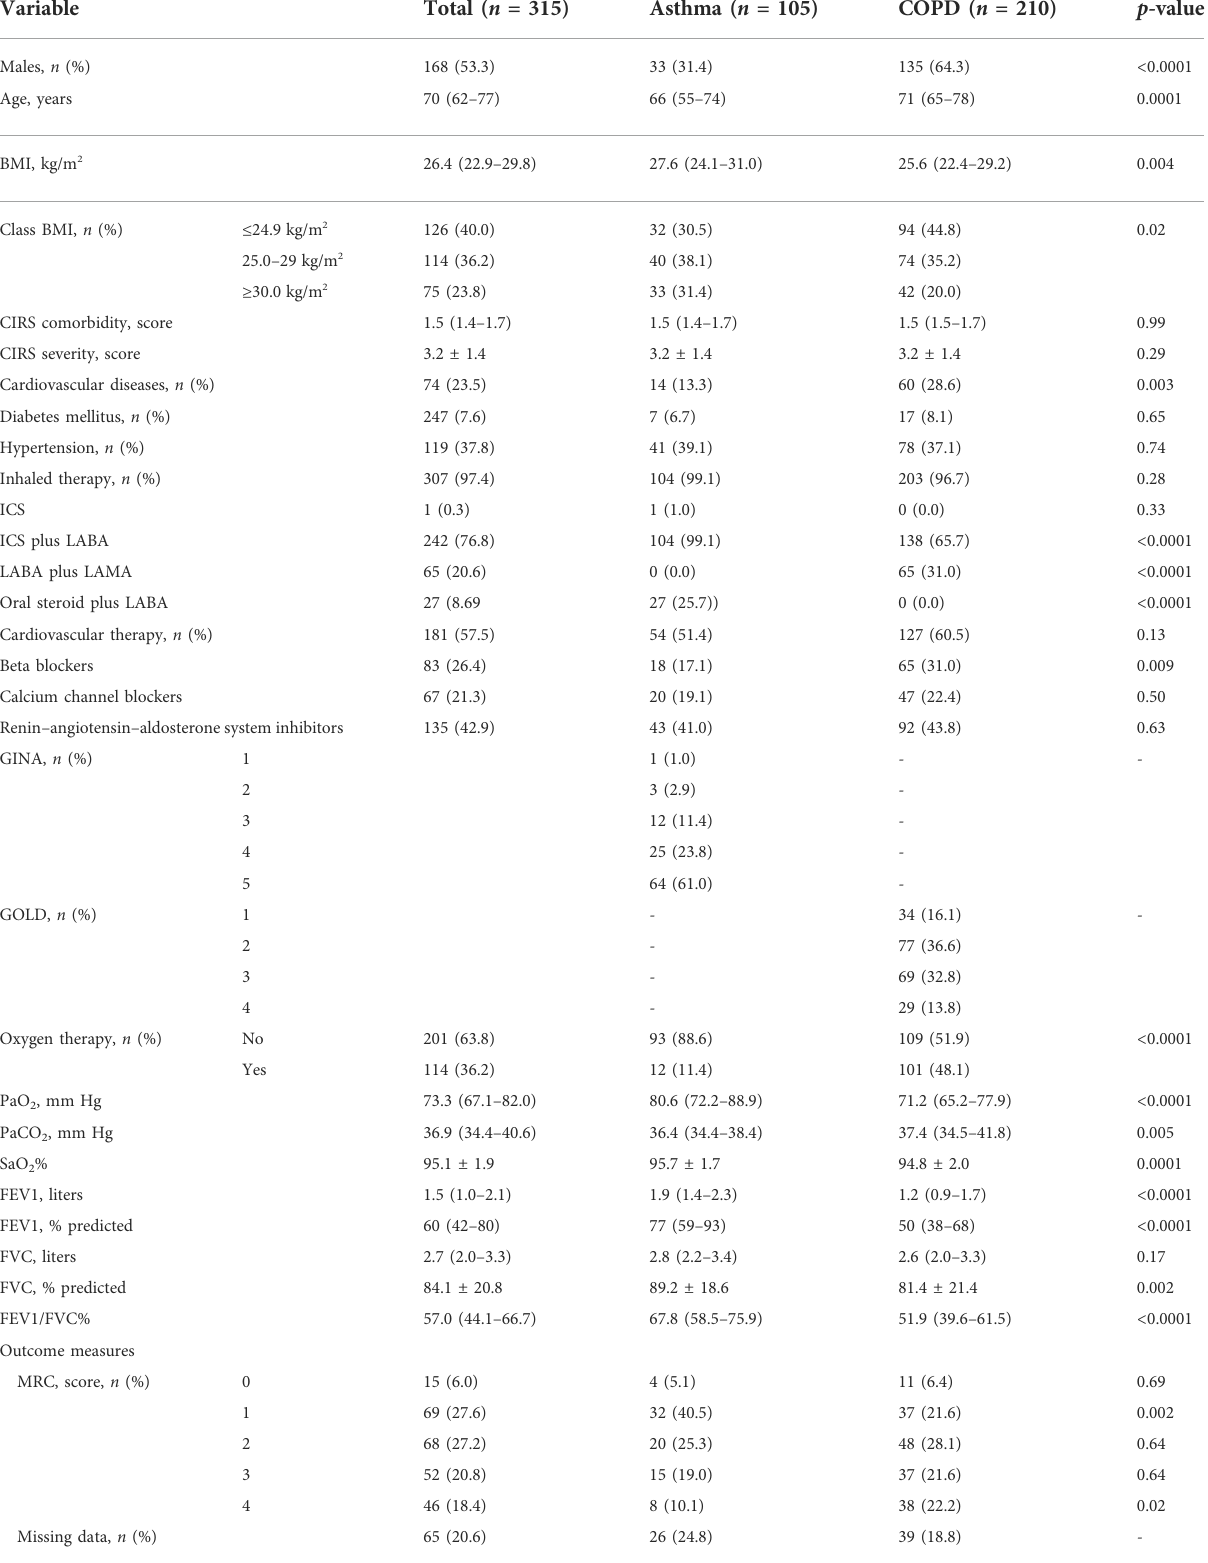
TABLE 1 Demographic, anthropometric, physiological, and clinical characteristics of